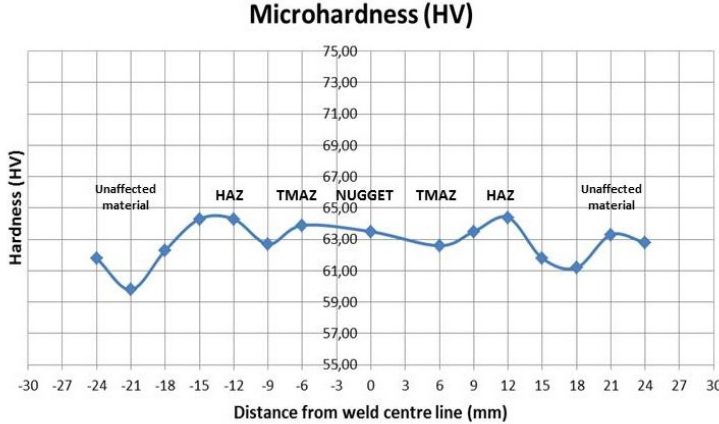
Figure 10. Microhardness distribution of Test 4.